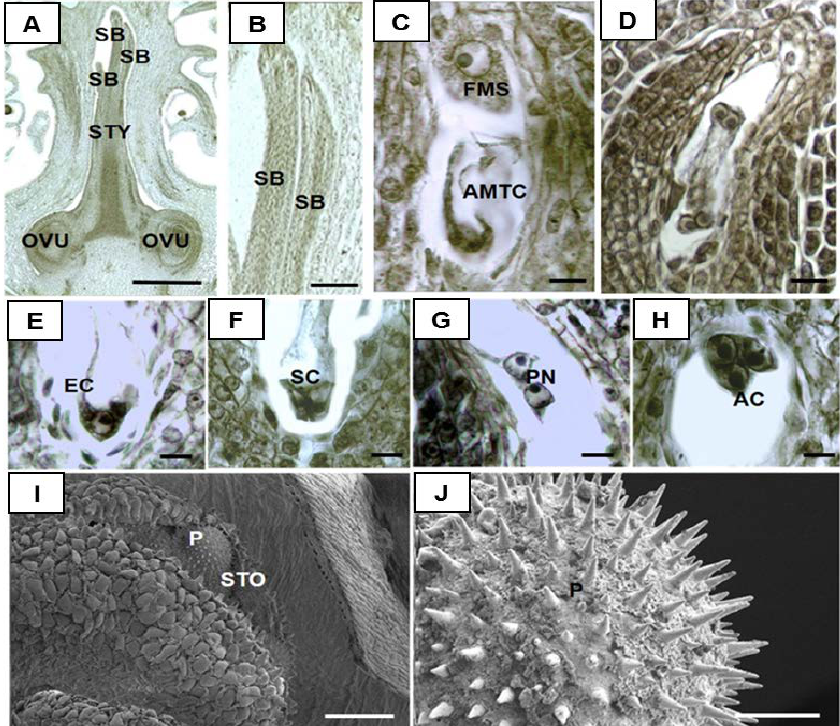
Fig. 8. Stage 11: Stigma formation. A. Ten branched stigma differantiation. B. Young stigma branches without papillae. C. Functional megaspore and atrophied megaspore cells. D. Four- nucleated embryo sac. E. Egg cell. F. Synergids. G. Polar nuclei. H. Antipodal cells. I. SEM analysis of anther dehiscence by stomium. J. SEM analysis of exine structure of mature pollen grain with short and spike like projections. AC: Antipodal cells, AMTC: Atrophied megaspore tetrad cells, EC: Egg cell, FMS: Functional megaspore, OVU: Ovule, P: Pollen, PN: Polar nuclei, SB: Stigmatic branches, SC: Synergid cells, STO: Stomium, STY: Style. Bar: 1 µm (C, D, E, F, G, H), 5 µm (B), 10 µm (A), 20 µm (J), 100 µm (I)